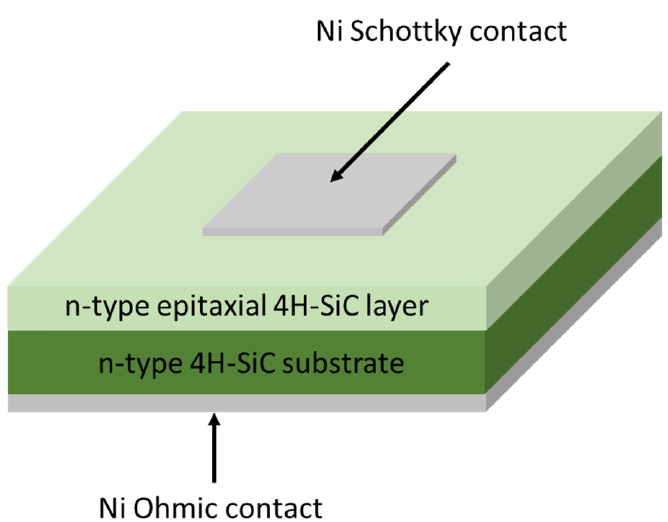
Figure 1. A scheme of the 4H-SiC SBD used for radiation detection.